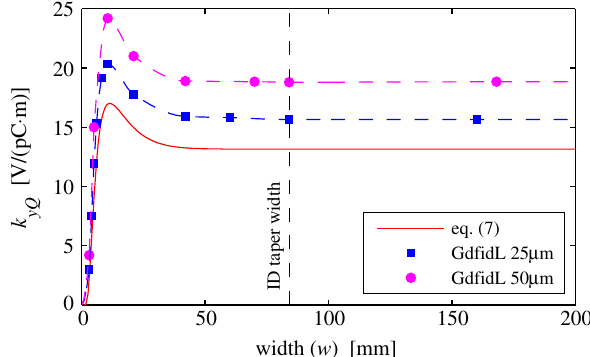
FIG. 6. Quadrupole kick factor — width dependence calculated for b ¼ 2 . 5